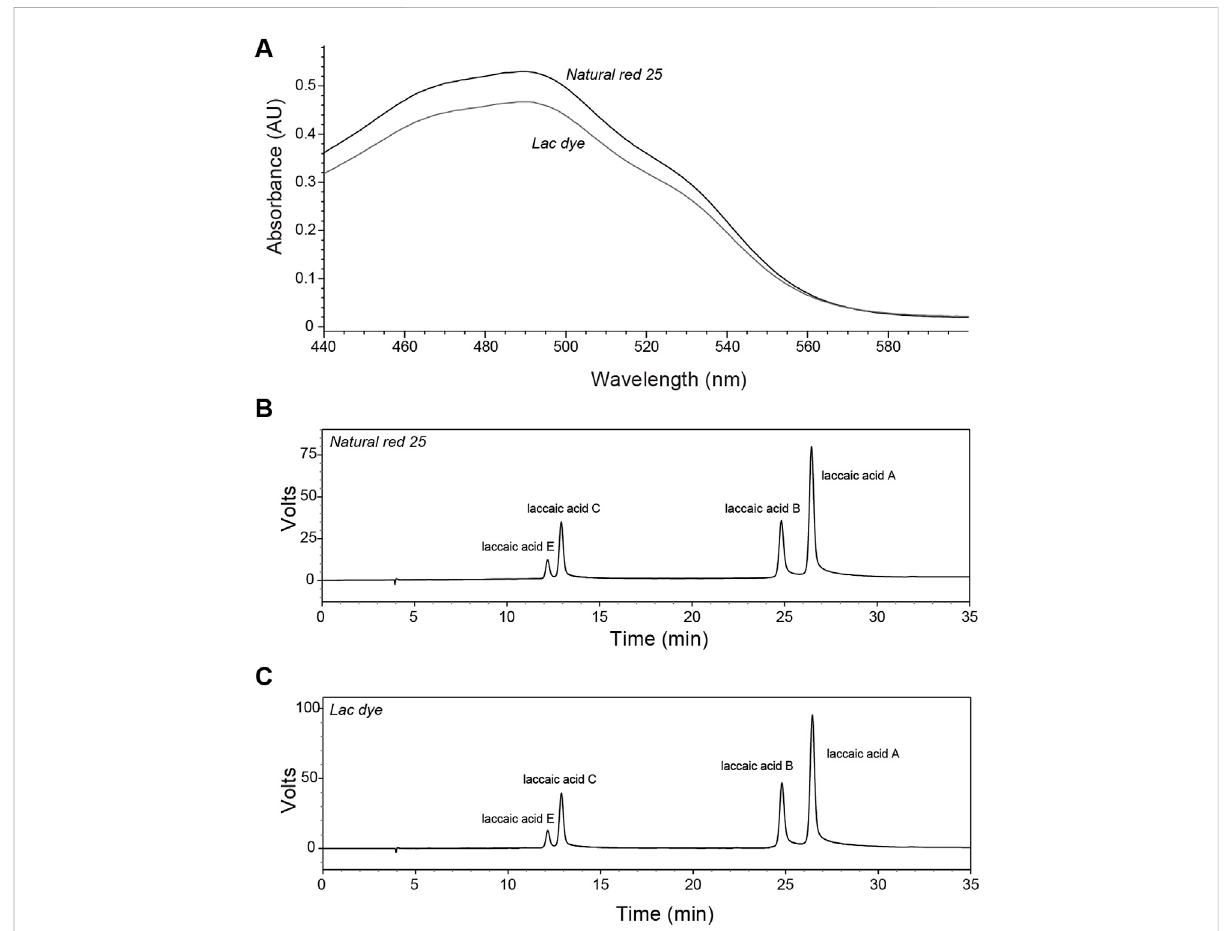
FIGURE 1 Characterization of lac dye by HPLC analysis. The test substance lac dye was analyzed using HPLC along with the reference compound natural red25. (A) Theabsorbance patterns ofthereference compound andlacdyewereobservedto becomparablewithlower values detectedfor lacdye intherangeofwavelengthshorterthan560 nm.Whenlaccaicacidisomerswerecompared,naturalred25 (B) andlacdye (C) showed highsimilarity incontaininglaccaicacidAasthemostabundantisomerwithoutlaccaicacidDexceptforthedifferenceintheratioofisomerBandCinthetest